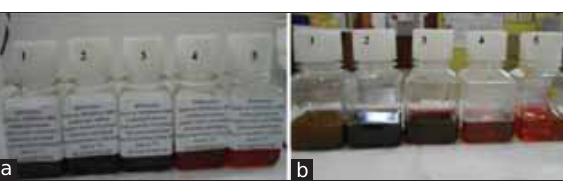
Figure-1: (a) Freshly prepared gold nanoparticles (GNPs) solution from 1 to 5(l) using 0.09375%, 0.1875%,